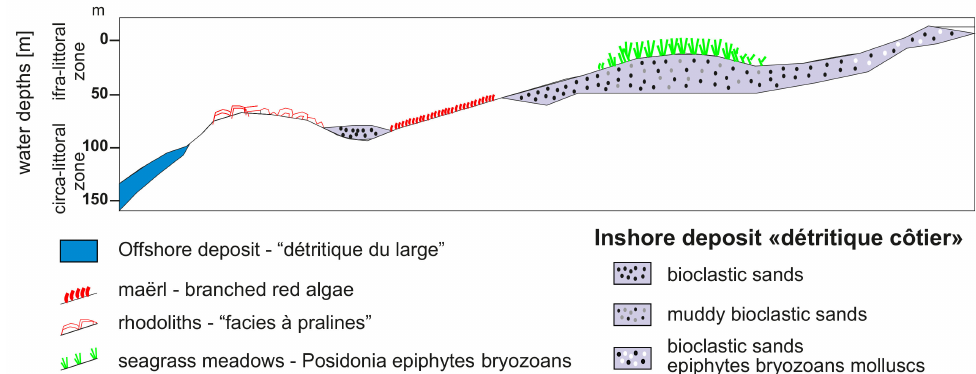
Figure 9. Sketch diagram showing the main biocenosis of the mobile sea